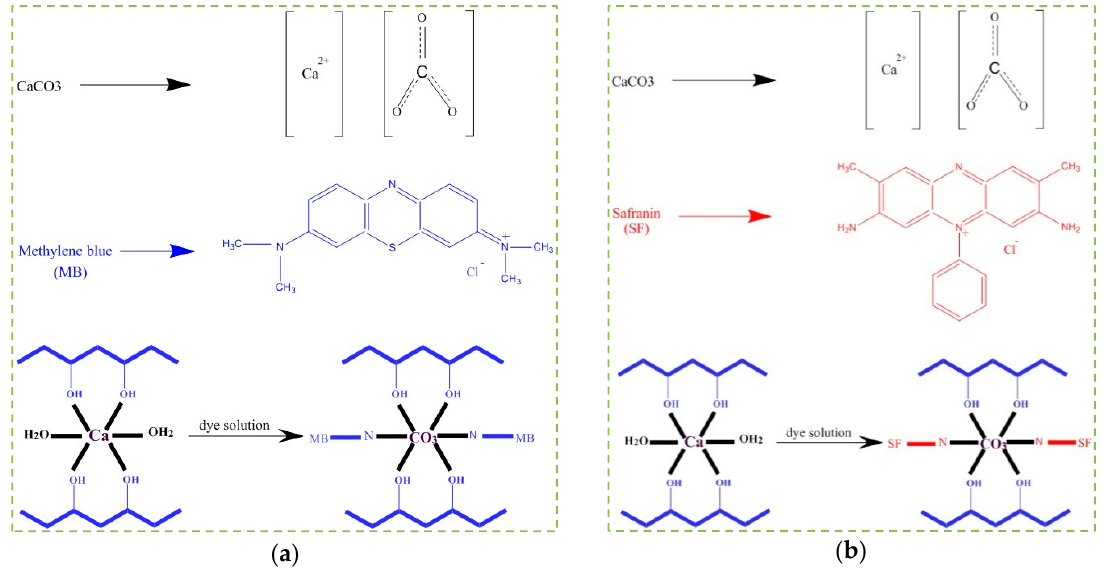
Figure 8. A suggested adsorption mechanism of PVA/CaCO 3 adsorbent for ( a ) MB, and ( b ) SF.